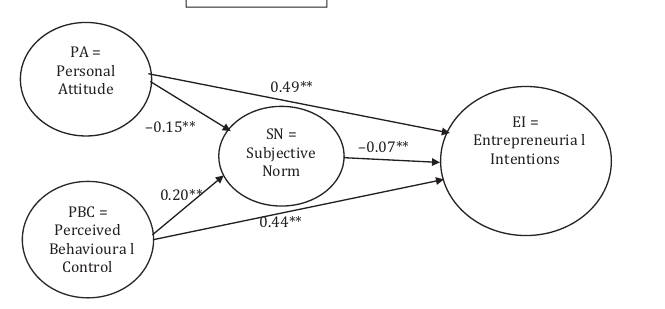
Figure 2. Redrawn model with standardised regression